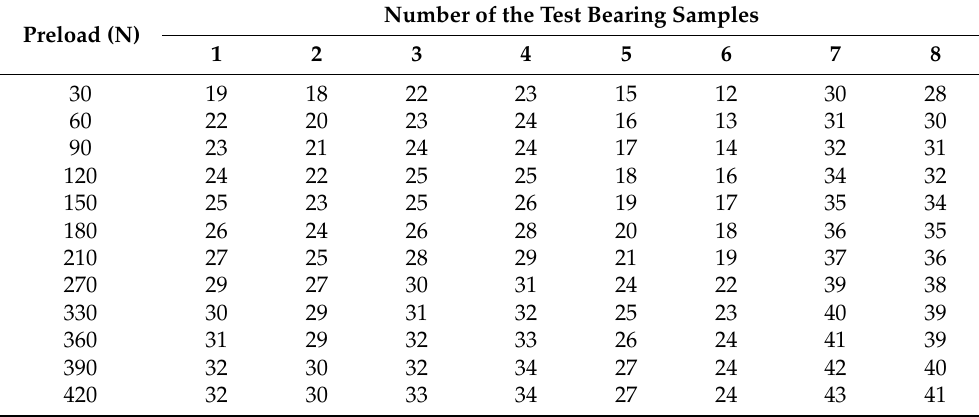
Table 3. Stickout measuring result of the test bearing samples under different preloads.